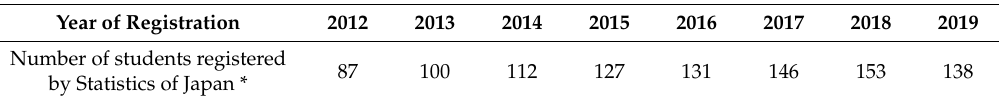
Table 2. Number of outbound students from Kazakhstan to Japan between 2012 and 2019.